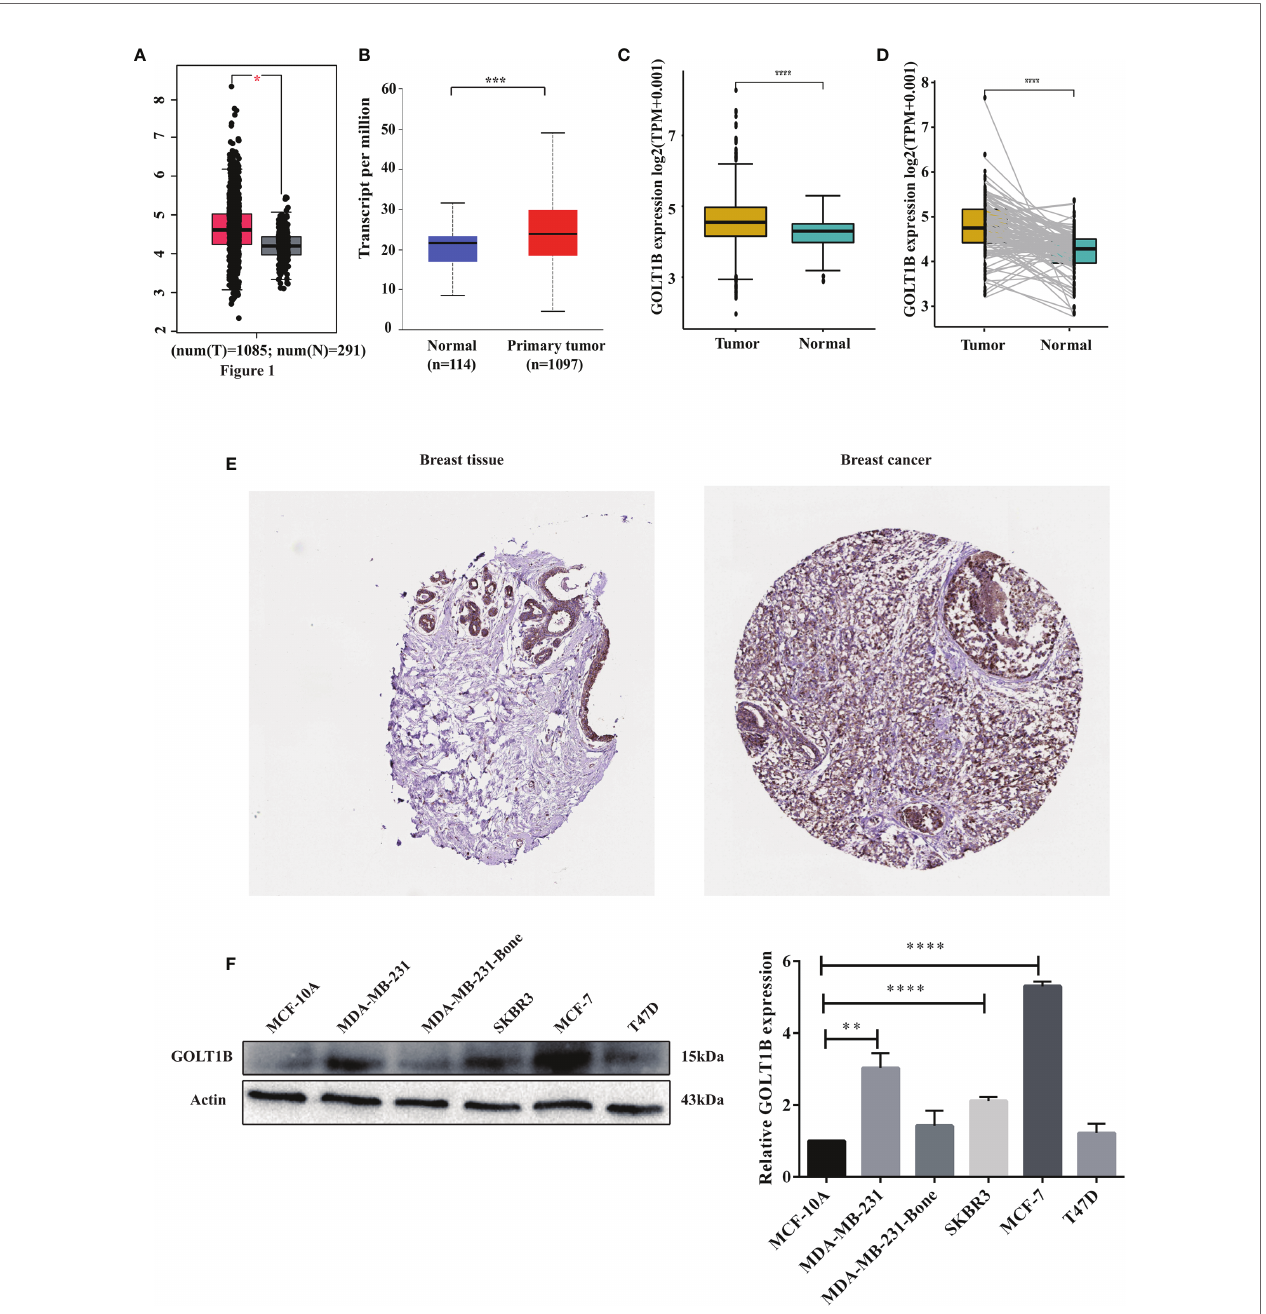
FIGURE 1 | The mRNA and protein expression of GOLT1B was up-regulatedin human breastcancer.The expression of GOLT1B in breast cancer tissues versusnormal tissues was investigatedusing the datasets from (A) the GEPIA database, (B) the UALCAN database, and (C) the TCGA database. (D) The GOLT1B expression in 112 paired breast cancer tissues andadjacent normal tissues using the datasets fromTCGA database. (E) The protein expression ofGOLT1B in breastcancer tissues and normalbreast tissues was evaluated through immunohistochemical tests fromThe Human Protein Atlas database. (F) Western blotting detectingGOLT1B expression in normalmammary epithelial cellline and breast cancer celllines. *p < 0.05, **p < 0.01, ***p < 0.001, ****p<